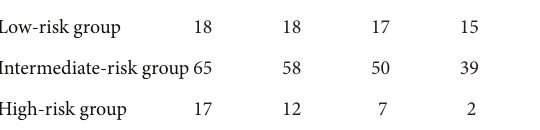
Figure 6: Risk classification according to the number of indepen- dent risk factors for overall survival. Patients were categorized into 3 groups according to the number of independent risk factors for overall survival: the low-risk group (patients with no risk factors), the intermediate-risk group (1 or 2 risk factors), and the high-risk group (3 or 4 risk factors). Risk classification revealed significantly poor prognosis by increasing the number of risk factors ( ∗ 𝑃 < 0.001 ). The patients with high-risk group showed significantly poor prognosis compared with those in the other